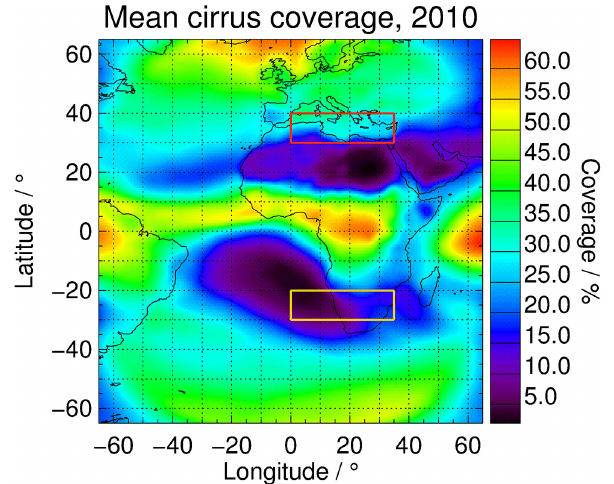
Figure 12. Mean ice optical thickness at a 15min temporal res- olution in the convective dominated regions MED (red) and SAC